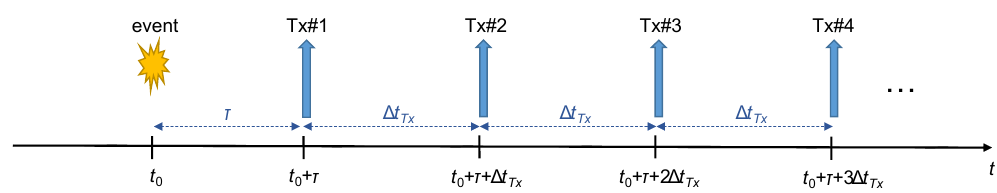
Figure 2. A single platoon vehicle’s transmission pattern, with the initial latency τ of the first message and the update period ∆ t Tx between the transmission of subsequent